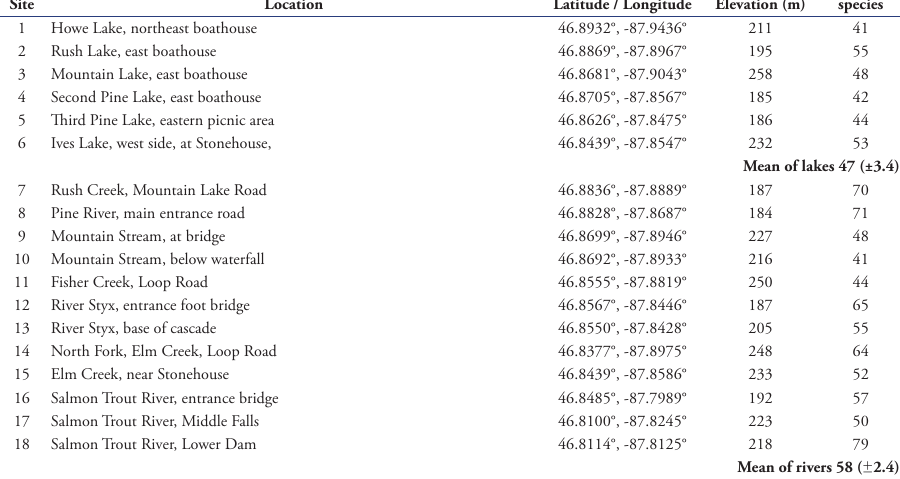
Table 1. The 18 sites sampled during this study with the total number of caddisfly species caught at each site. Site numbers correspond to Fig. 1 and Table 2. All sites were sampled once during June, July, August, and September 2019. Mean species richness was the same in rivers as in lakes based on a non-parametric Mann-Whitney U -test between the habitat types ( P = 0.065).